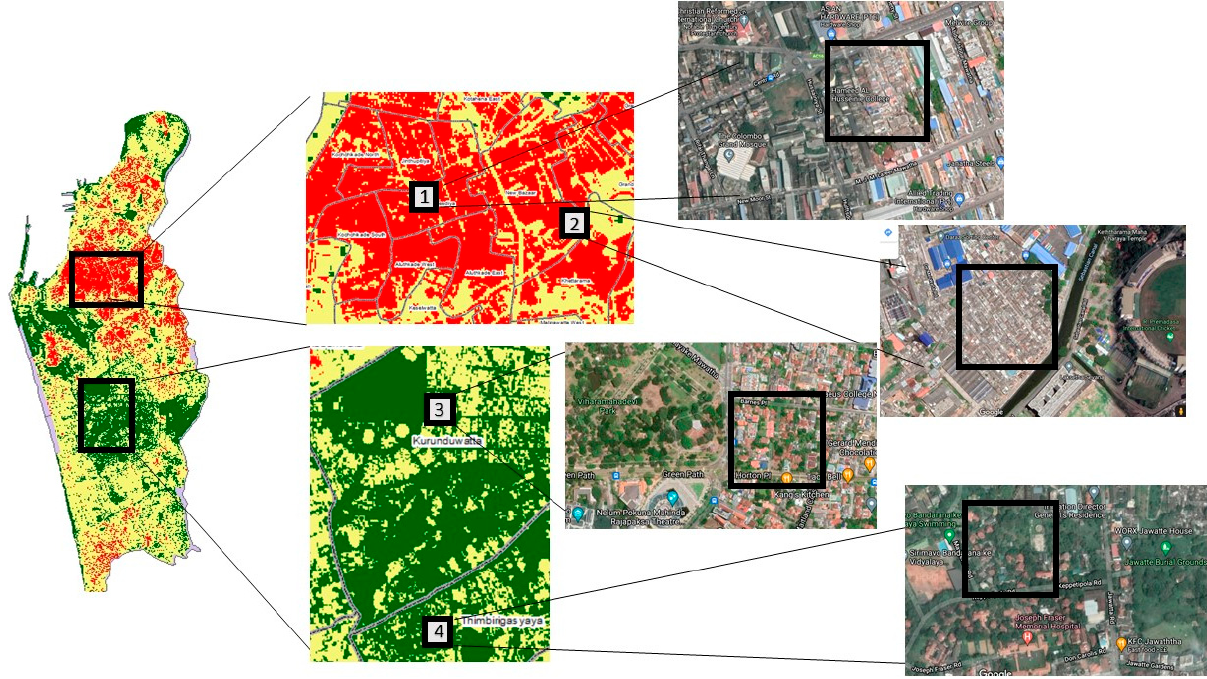
Figure 5. Selected locations for estimation of heat risk reduction. Note: Please refer to Figure 8 for heat risk categories (green = ‘low,’ yellow = ‘moderate’ and red = ‘high’). The image on left is identical to the heat risk map of Colombo in Figure 8. The purpose is to contextualise the selected locations. Table 11. Selected locations for heat risk estimation legend and descriptions.